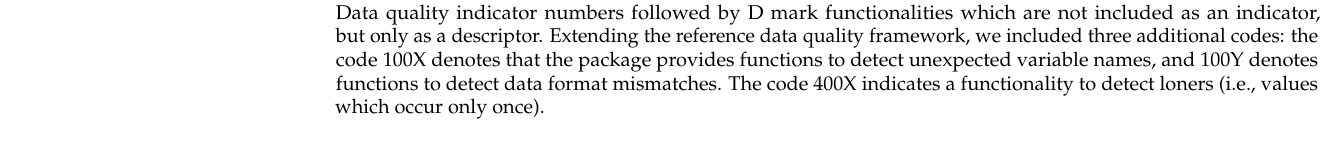
Table A7. Data quality assessment capabilities by package